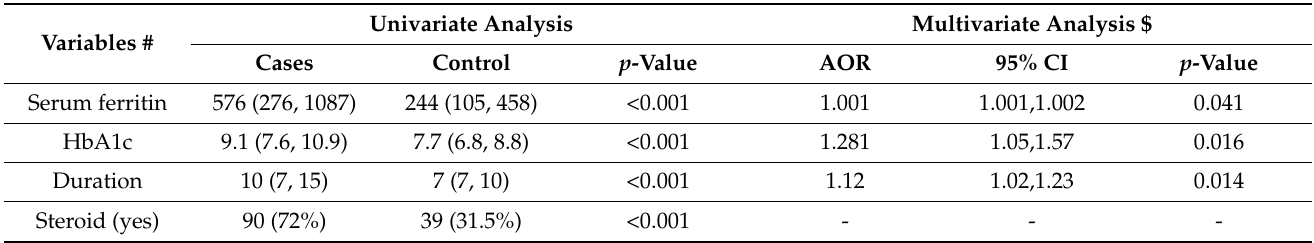
Table 3. Predictors of the invasive fungal sinusitis in propensity score-matched data for age, comor- bidity, and respiratory